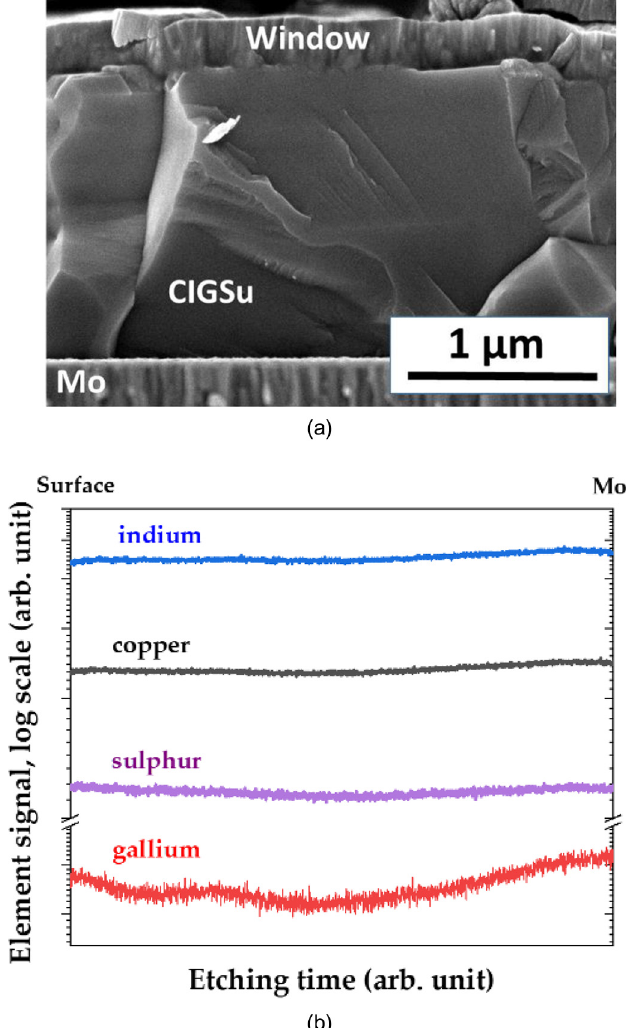
Fig. 5. (a) Scanning electron microscopy cross sectional image of a solar cell based on Cu(In,Ga)S 2 fi lm synthesized following the modi fi ed three-stage process investigated herein. (b) Qualitative pro fi les of gallium (in red), indium (in blue), copper (in black) and sulphur (in violet) measured by glow discharge optical emission spectrometry throughout a completed